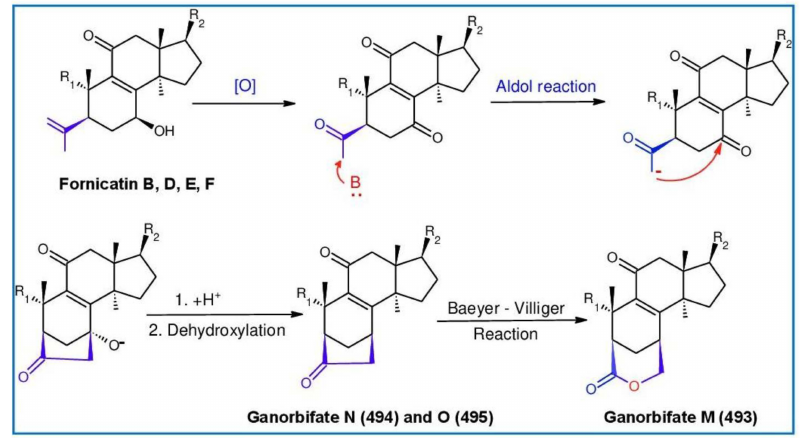
Figure 34. Plausible biosynthetic pathway of ganorbifates M, N, and O ( 493 – 495